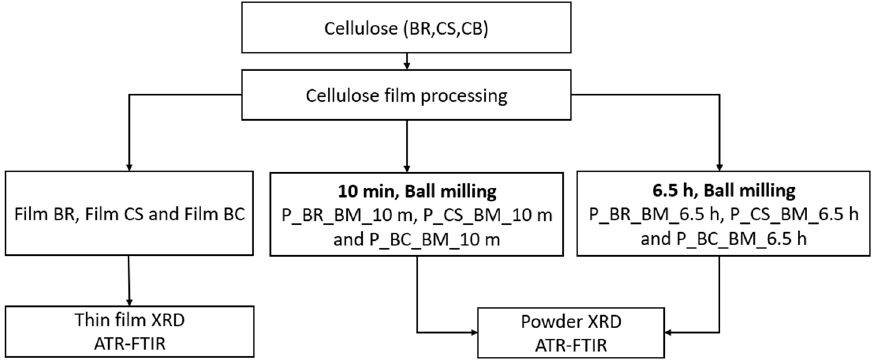
Figure 1. Flow process diagram. Cellulose from banana rachis (BR), a commercial sample (CS), and bacterial cellulose (BC) were used. Three samples were obtained from each cellulose type: an unmilled sample (film), a sample ball-milled for 10 min (P_BR_BM_10 m, P_CS_BM_10 m, and P_BC_BM_10 m), and one ball-milled for 6.5 h (P_BR_BM_6.5 h, P_CS_BM_6.5 h, and P_BC_BM_6.5 h).